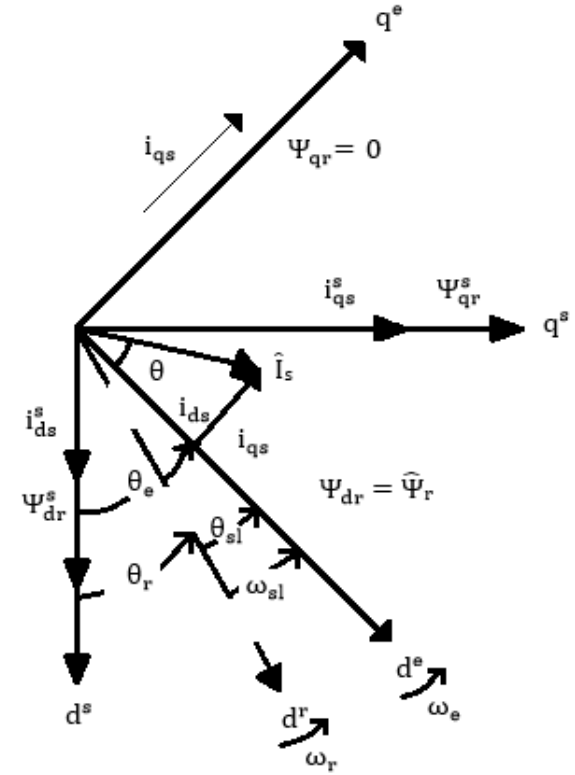
Figure 1. Phasor diagram of indirect vector control